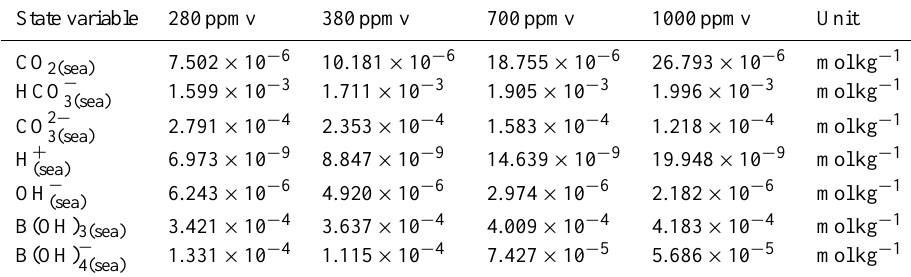
Table 3. Initial conditions of state variables for p CO 2 scenarios at TA=2300µmolkg − 1